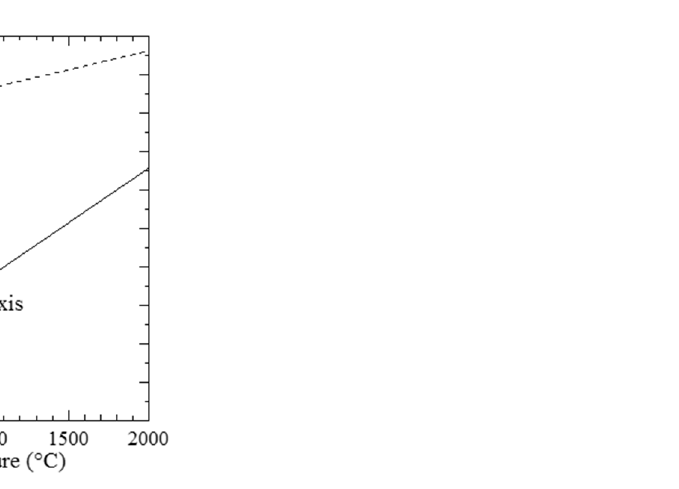
Figure 4. Temperature dependence of expansion ratio of a - and c -axes for SCAM crystal.